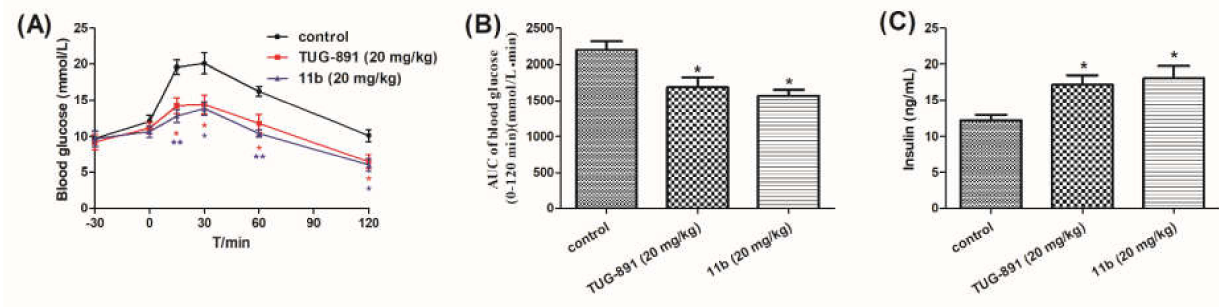
Figure 4. Effects of compound 11b and TUG-891 on plasma glucose levels during oGTT in fasting DIO mice. ( A ) The changes of blood glucose levels after oral administration of compound 11b , followed by the oral glucose load (2 g/kg); ( B ) AUC -30–120 min of plasma glucose levels. ( C ) Insulin levels at 30 min after the glucose load. Values are expressed as the mean ± SEM ( n = 6). * p ≤ 0.05 compared with vehicle-treated DIO mice by Student’s t test; ** p ≤ 0.01 compared with vehicle-treated DIO mice by Student’s t